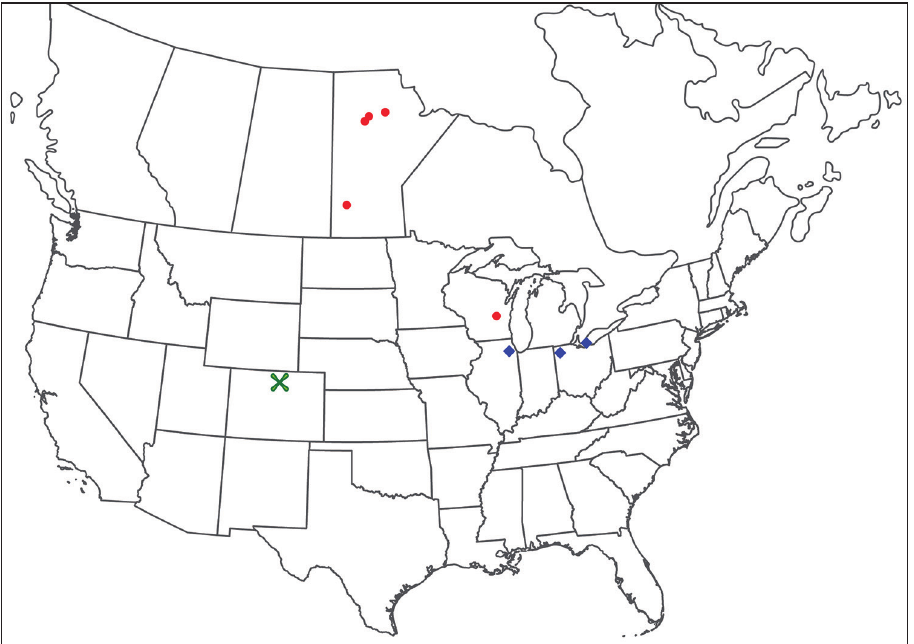
Figure 96. Torrenticola indistincta distribution. Red dots indicate material examined. Blue diamonds indicate previously published reports. Green “X” indicates previously published report (Young 1969) that requires verification of